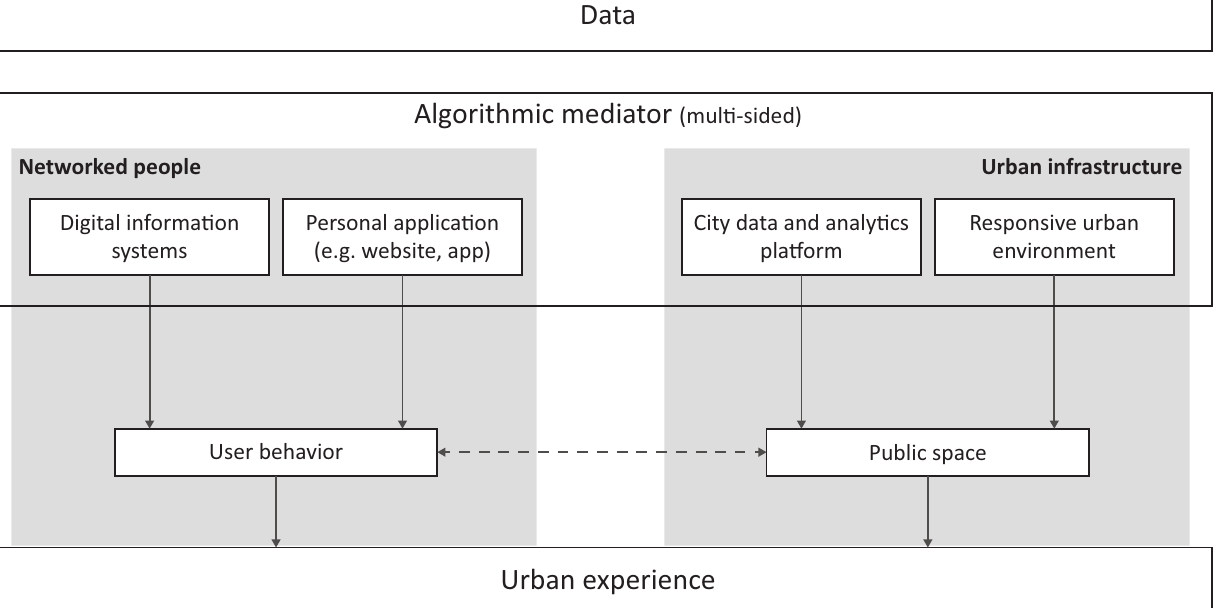
Figure 2. Framework on algorithmic curation of urban